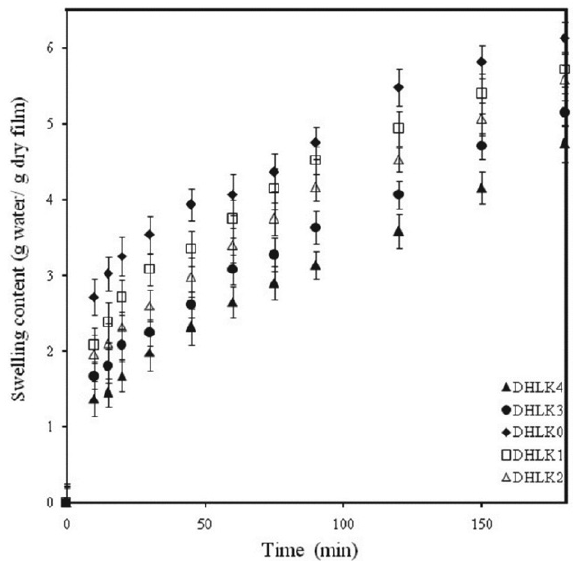
Figure 3. Swelling content of film of HPMC K100 LVCR (H L ) ma- trix with varied kaolin